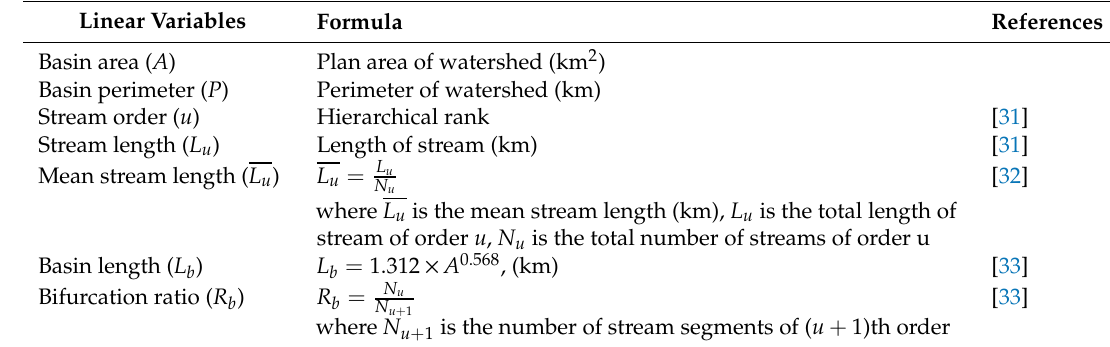
Table 1. Linear morphometric variables computation formulae with